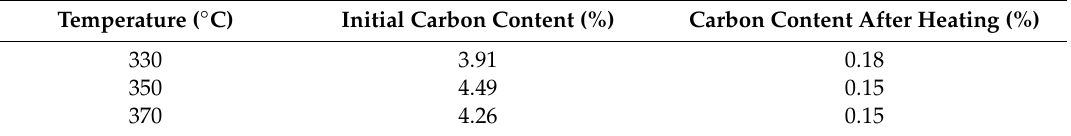
Table 2. Carbon content before and after soot oxidation at 330, 350 and 370 °C for 30 min.